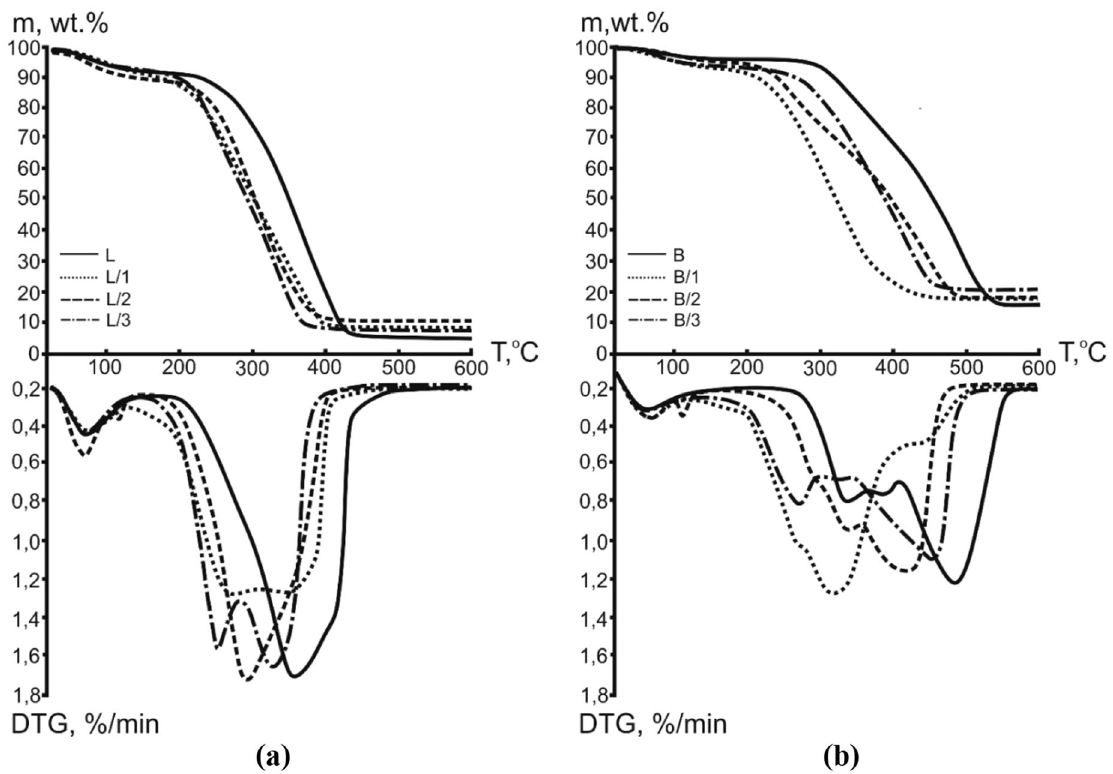
Fig. 3 TG- and DTG-curves for the oxidation of energetic coals modified with copper salts: a L series; b B series. The flow rate is 60 mL/min (air), the heating rate is 2.5 (cid:3) C/min, the temperature range is 45–600 (cid:3) C, the sample loading is about 17